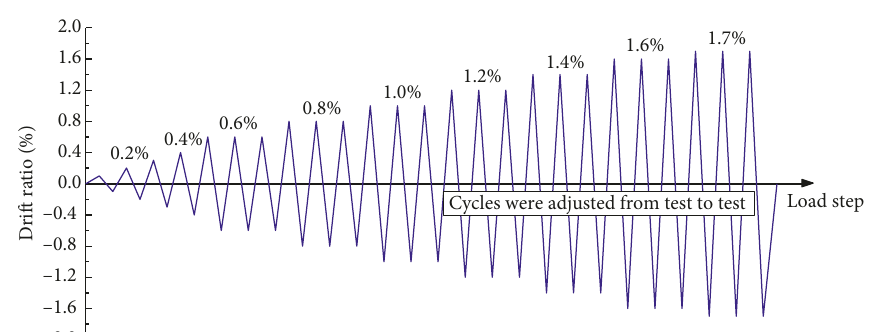
Figure 2: Test setup.